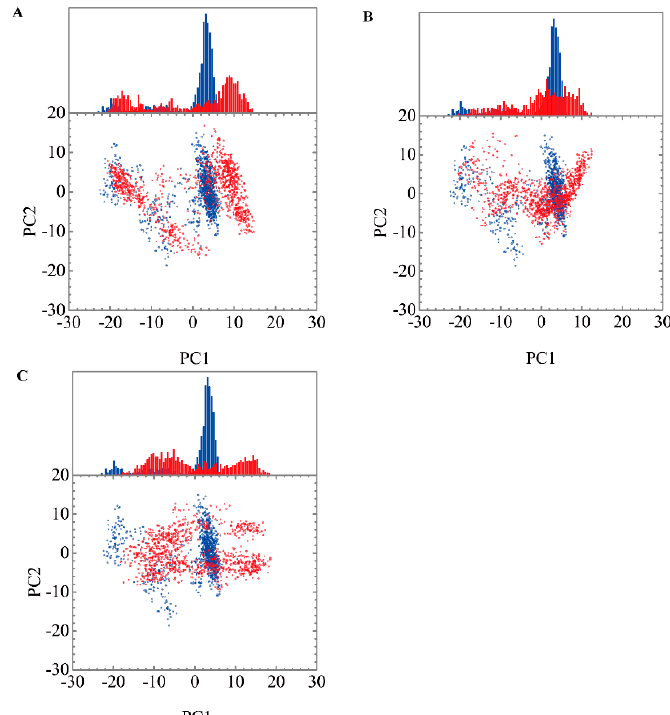
Figure 9. Eigenvector distribution of paraplegin protein in apo form (blue) and paraplegin complexes (red) with ( A ) 5-hydroxy- L -tryptophan; ( B ) saussureamine C; and ( C ) 3-(2-carboxyphenyl)-4(3 H )-quinazolinone.